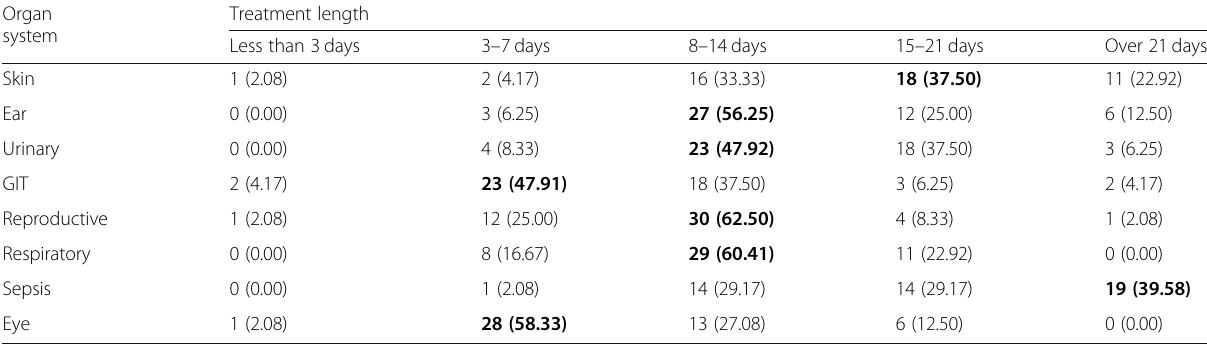
Table 3 Duration of treatment (columns) for different organ systems (rows). Cells show the frequency and percentage of responses (in brackets). The cells in bold represent the most used duration of treatment for every organ system Organ system